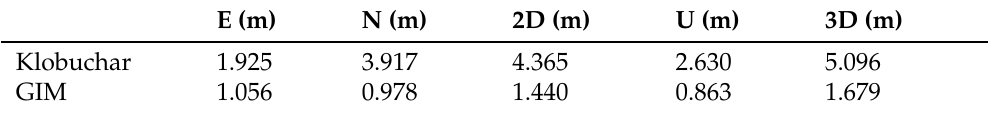
Table 8. RMS values of Klobuchar–based and GIM–based SF RT–PPP solutions in the east, north, horizontal, up, and 3D directions from 10:00 to 22:00 on 12 September